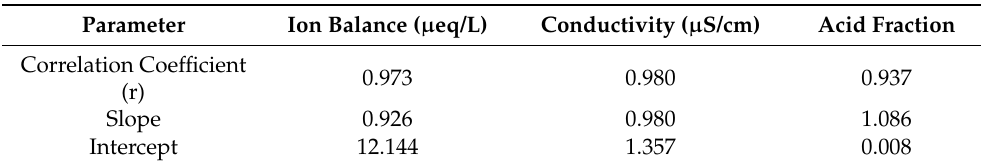
Table 2. Evaluation of analytical data using three accuracy parameters: ion balance, electric conduc- tivity, and acid fraction (n = 924).